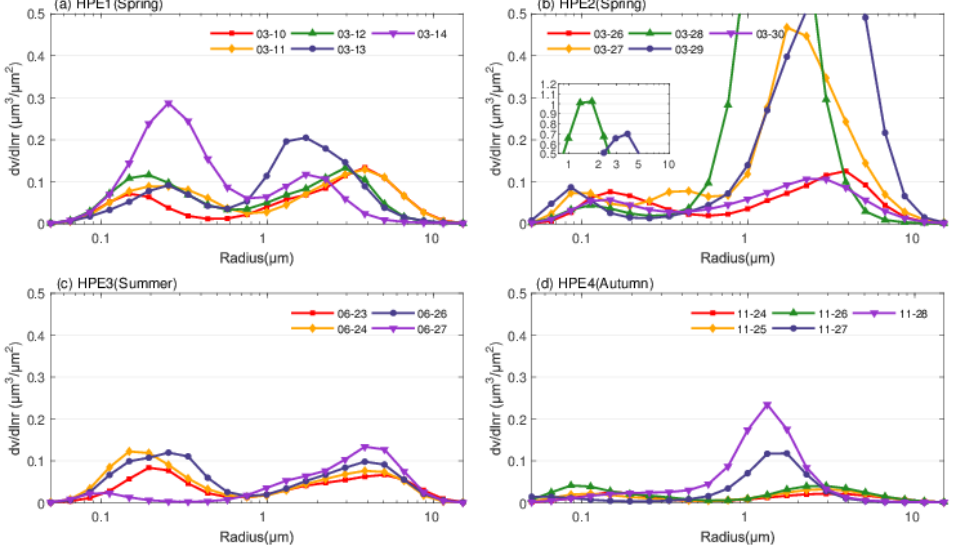
Figure 5. Daily variation in aerosol volume–size distributions for the whole column during heavy pollution episodes (HPE1, 2, 3, and 4) in Beijing in 2018.